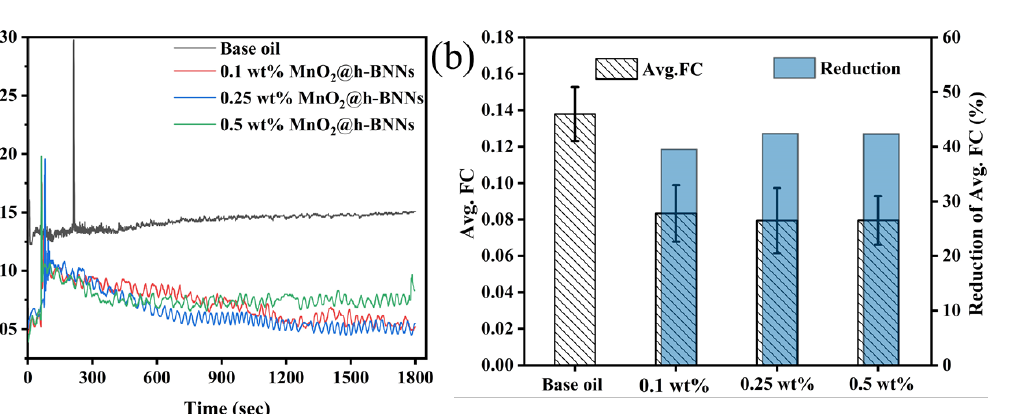
Figure 4a,b shows the friction test curves and the Avg. FC for different additives.